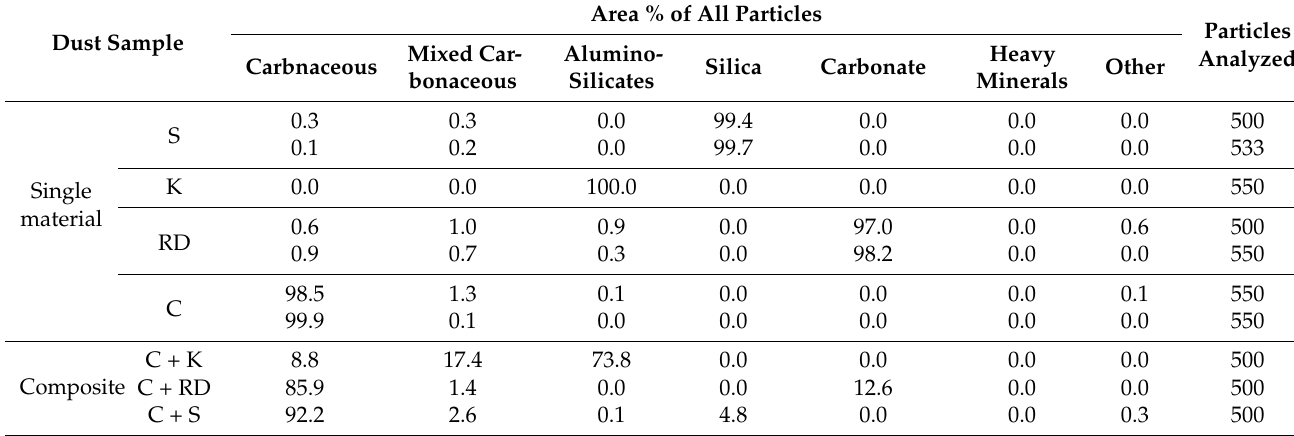
Table 4. SEM-EDX classification results on the single-material and composite samples containing coal plus one mineral. Dust Sample